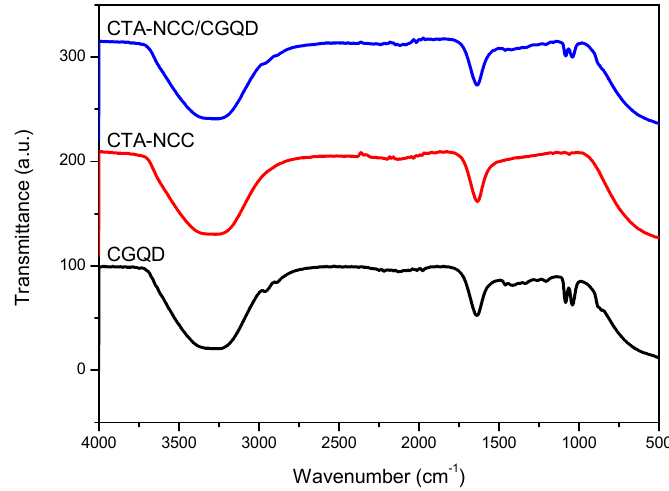
Figure 3. FTIR spectrum of CGQD, CTA-NCC and CTA-NCC/CGQD solutions.